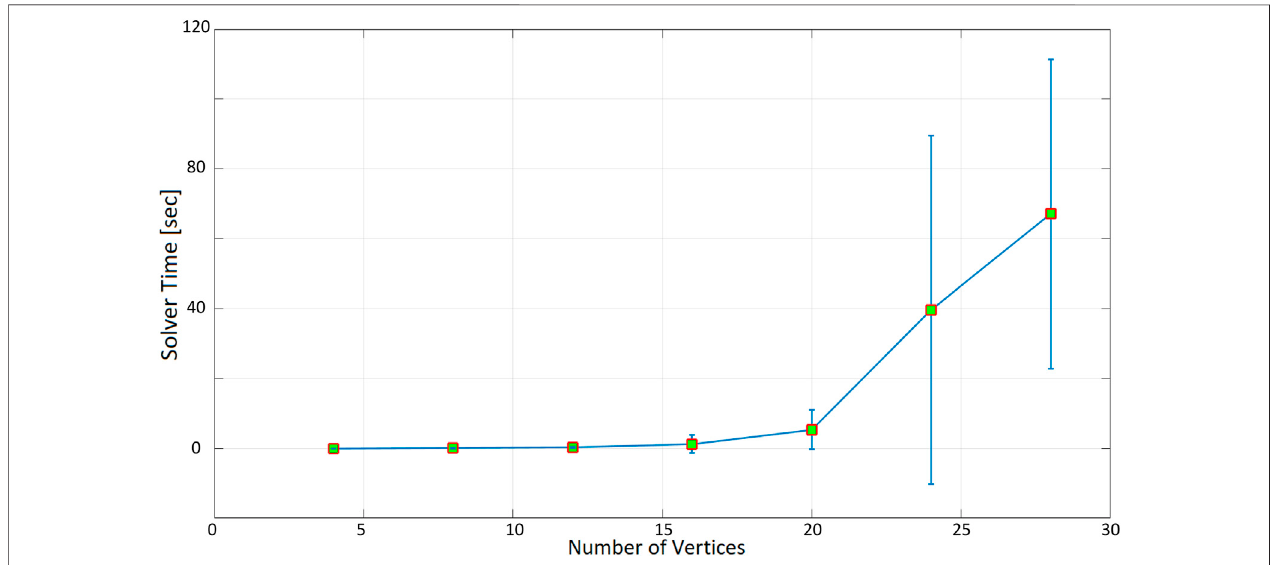
FIGURE 10 | Optimization time (average and standard deviation) versus number of vertices, with the number of targets equal to the number of social charging stations, inspection time spent in targets equal to 60 s.